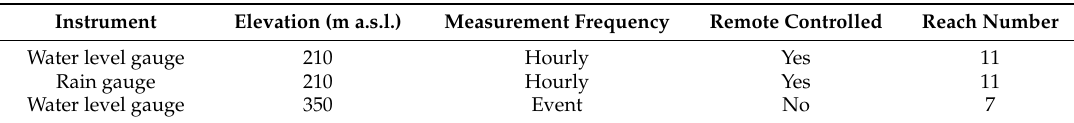
Table 1. Main instruments available in the Caldone River. Elevation expressed as Above sea level (a.s.l.).